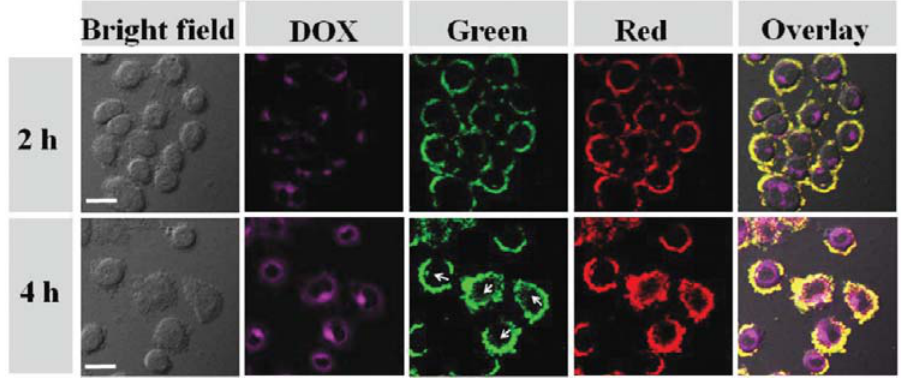
Figure 7. Confocal laser scanning microscopy (CLSM) images of HeLa cells after incubation with UCNPs@Au ‐ DOX for 2 and 4 h, respectively; the rose red emission from DOX was collected at 550–700 nm under excitation of 488 nm; upconversion luminescence (UCL) emission was collected by a green UCL channel at 500–600 nm and a red channel at 600–700 nm, λ ex = 980 nm, 500 mW. UCNP =